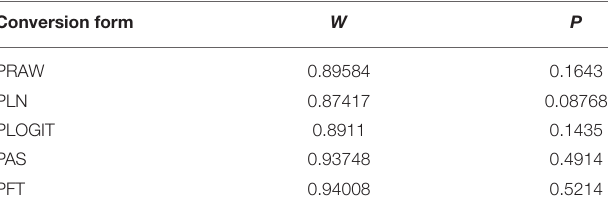
TABLE 3 | Normal distribution test and conversion forms for the normal distribution of prevalence (Molecular methods).